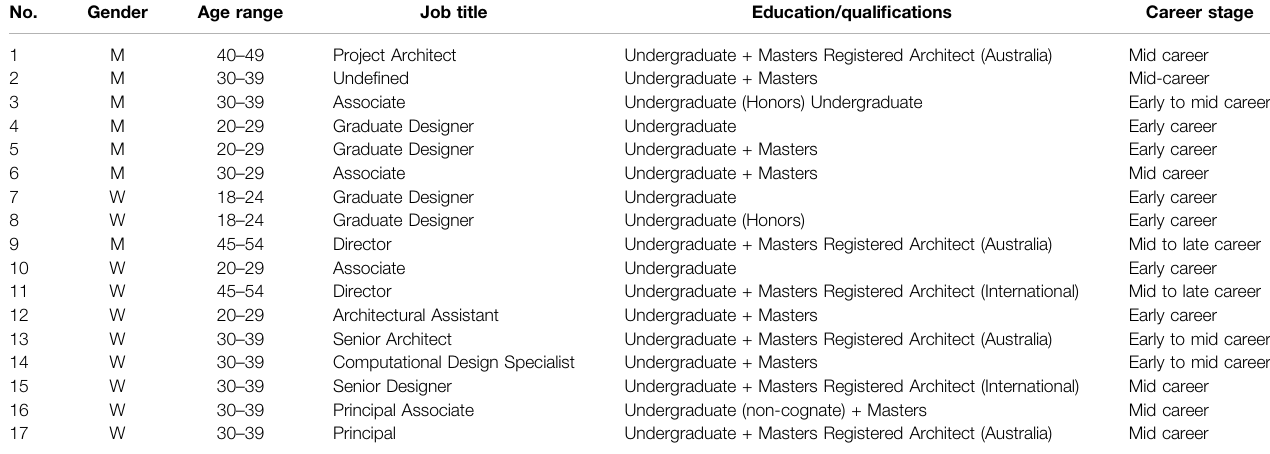
TABLE 2 | Interviewee pro fi